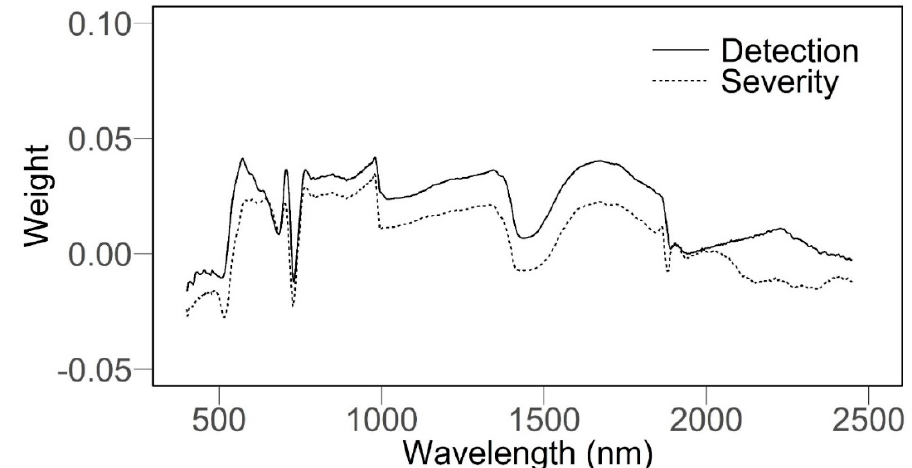
Figure 5. Wavelength weight values for SCR detection and severity classification calculated by the RELIEF-F algorithm. The higher the value, the higher the discrimination power.